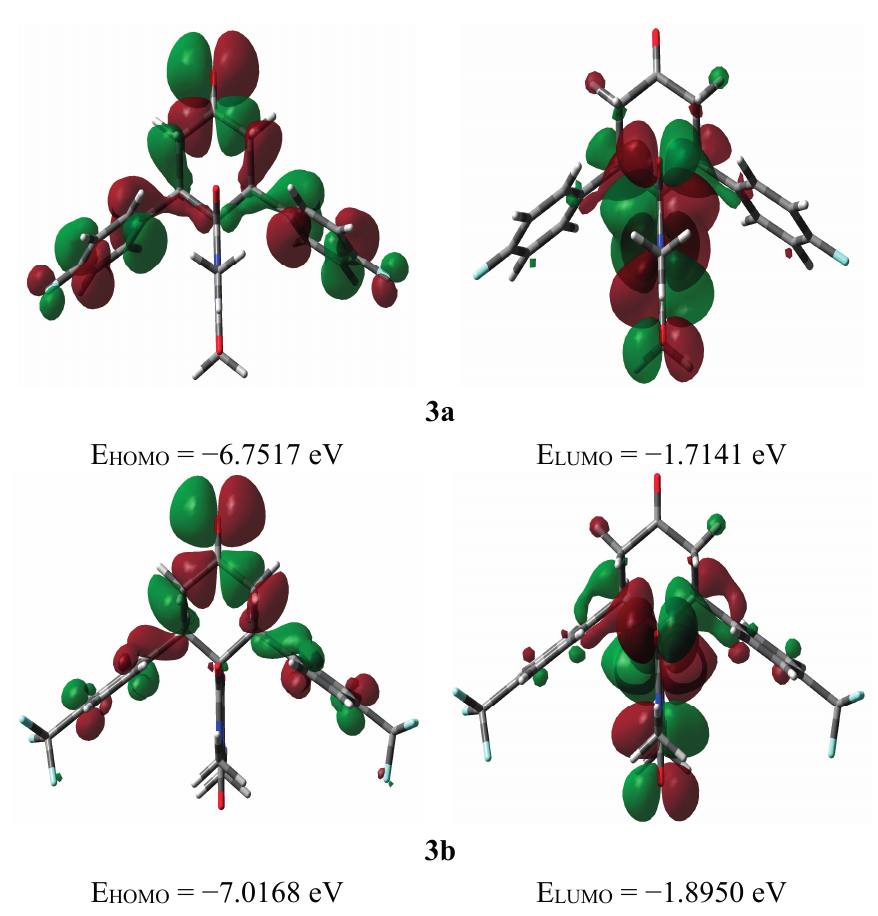
Figure 8. The ground state isodensity surface plots for the frontier molecular